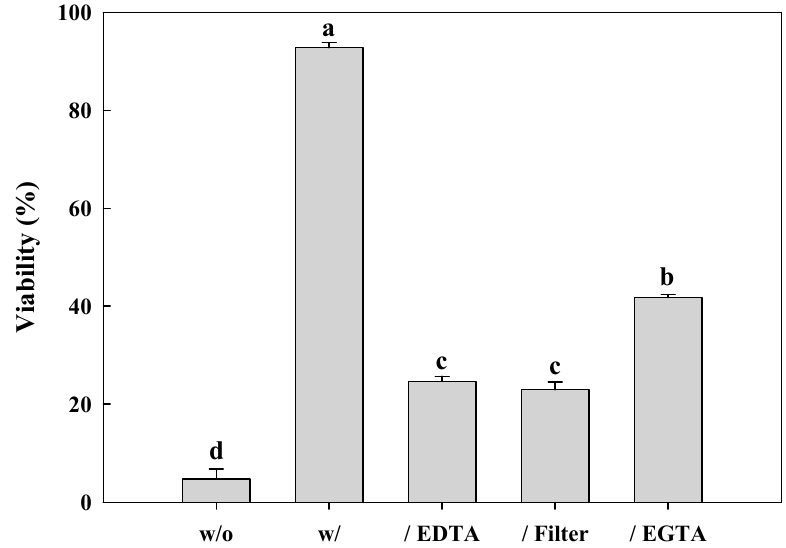
Figure 1. Soy powder improves the viability of freeze-dried Lactobacillus brevis WiKim0069. The graphs show the viability of bacterial cells after freeze drying for 72 h in the presence or absence of soy powder pretreated or not with ethylenediaminetetraacetic acid (EDTA), a cationic resin filter, or ethylene